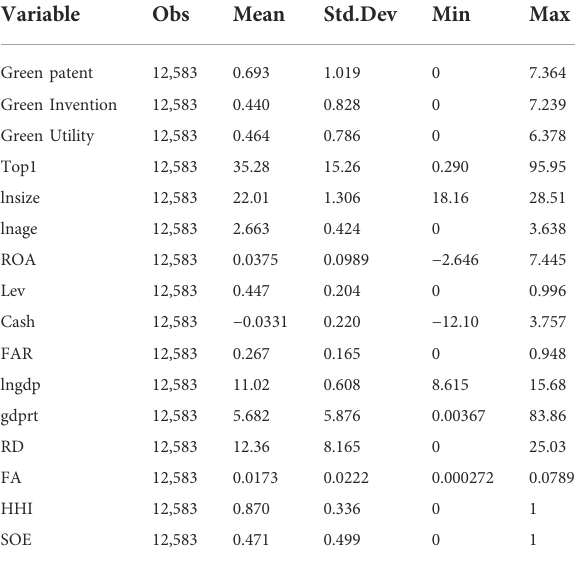
TABLE 1 Descriptive statistics.